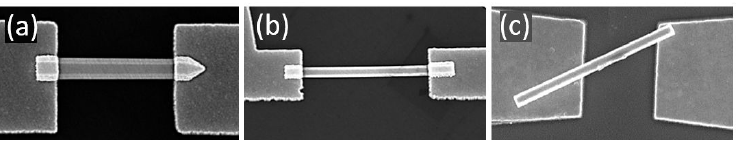
Figure 2. SEM images of the GaN NWs with the diameters of 350 nm ( a ) and 200 nm ( b ) contacted by the Au electrodes deposited above the NWs. ( c ) The NW with the diameter of 200 nm contacted on the top of the Au electrodes by melting procedure (see text for